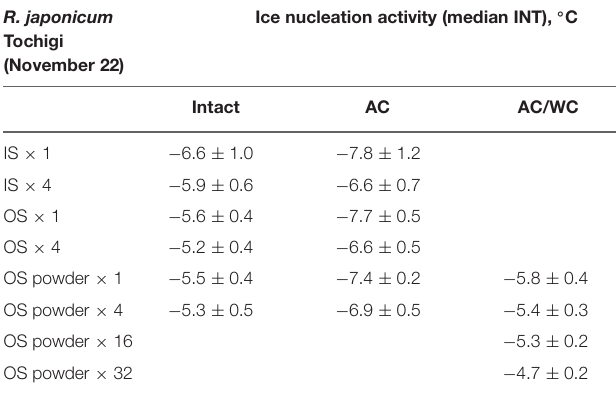
TABLE 1 | Ice nucleation activity (INA) in various tissues of Rhododendron japonicum flower buds collected from various sites. Collection sites and dates